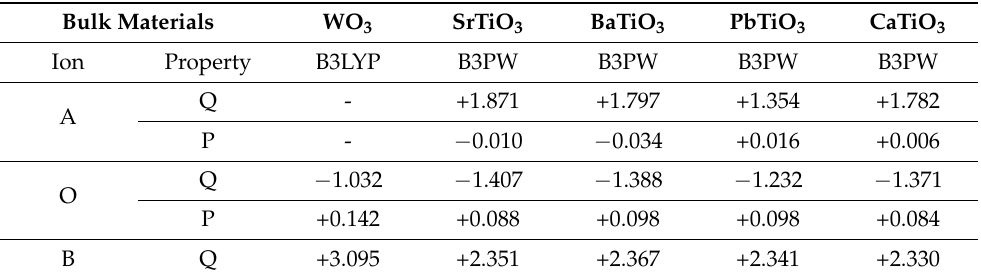
Table 3. Our calculated atomic charges Q ( e ) as well as bond populations P ( e ) in WO 3 , SrTiO 3 , BaTiO 3 , PbTiO 3 and CaTiO 3 bulk materials.